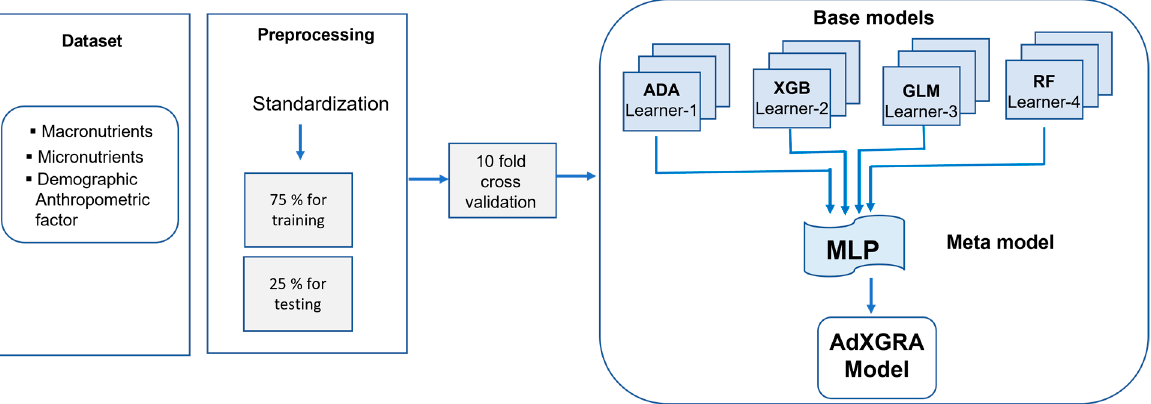
Figure 1. Flow diagram of the proposed AdXGRA